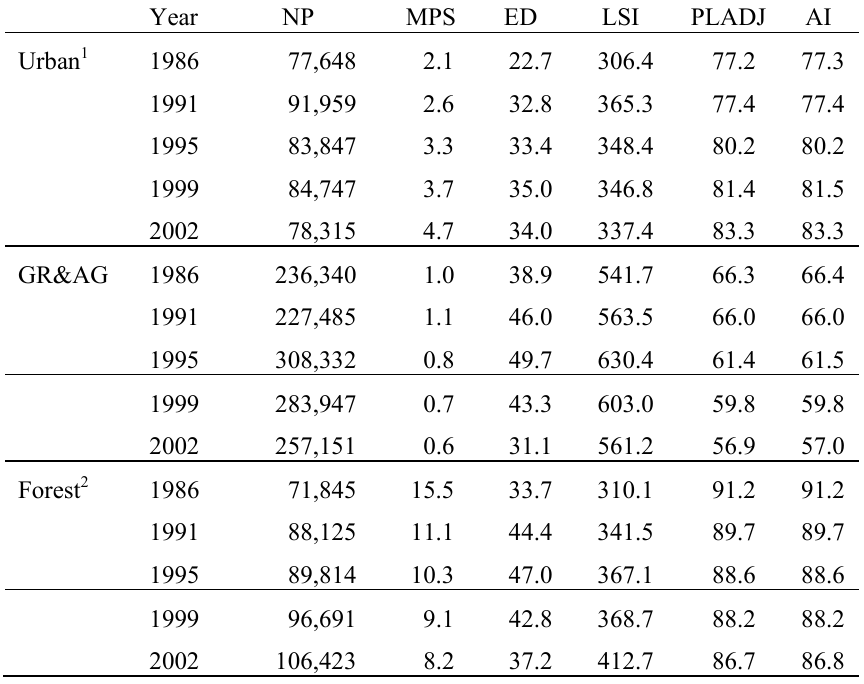
Table 4. Basic land cover composition and configuration metrics over time (NP = number of patches, MPS = mean patch size [ha], ED = edge density [m/ha], LSI = landscape shape index, PLADJ = percentage of like adjacencies, AI = aggregation index [56].